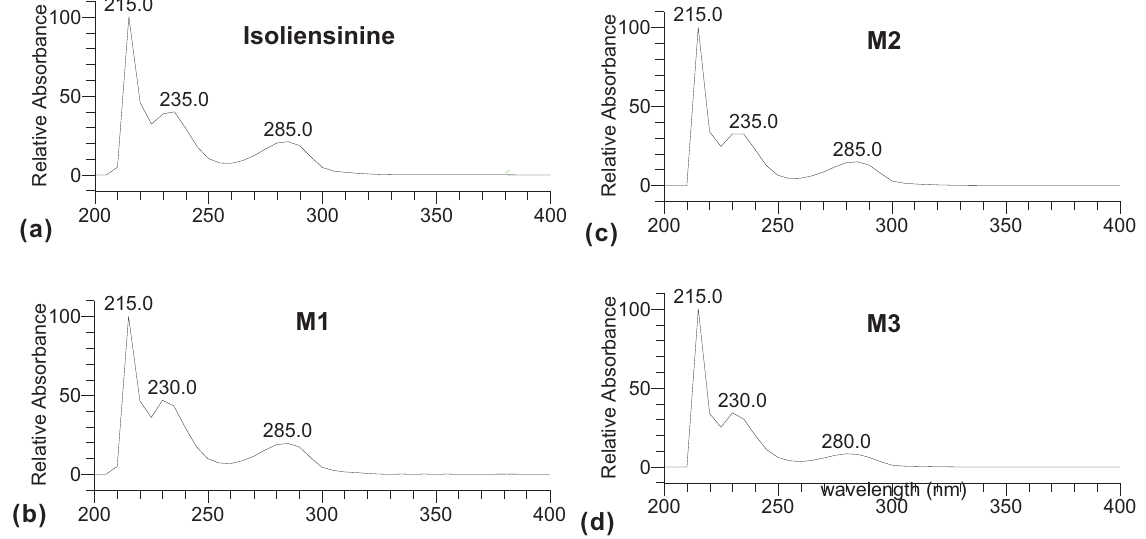
Figure 2. DAD spectra of ( a ) standard isoliensinine and ( b – d ) its microsomal metabolites M1 – 3